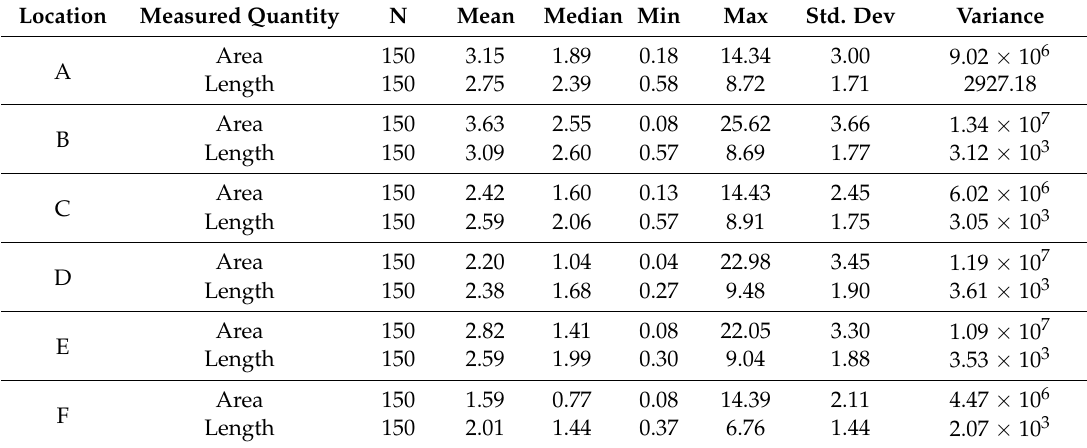
Table 3. Descriptive statistics of studied points on briquettes’ surface (in mm/mm 2 ).